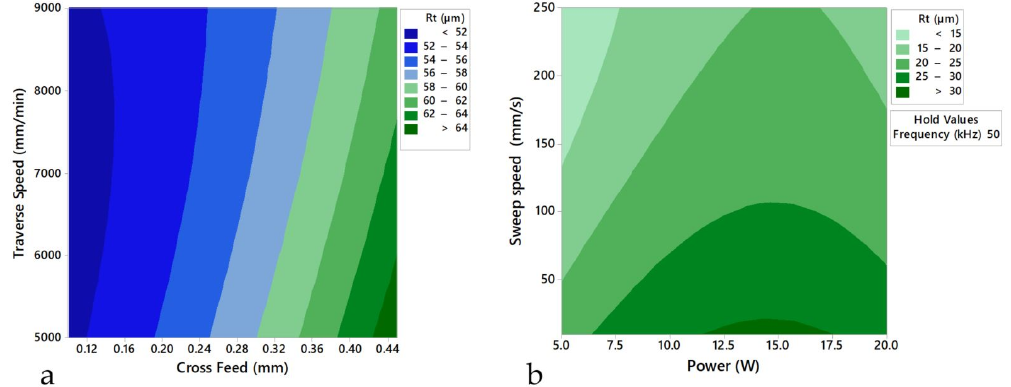
Figure 17. Contour diagrams of the surface quality obtained for: ( a ) Abrasive water jet texturing; ( b ) Laser surface texturing.